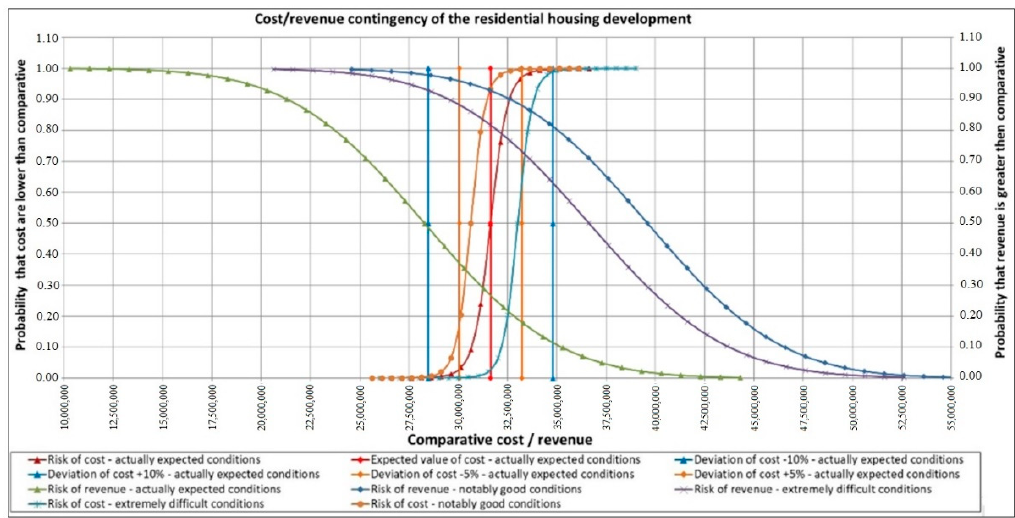
Figure 3. Comparative risk characterization of the costs and revenues of the residential housing development 3.